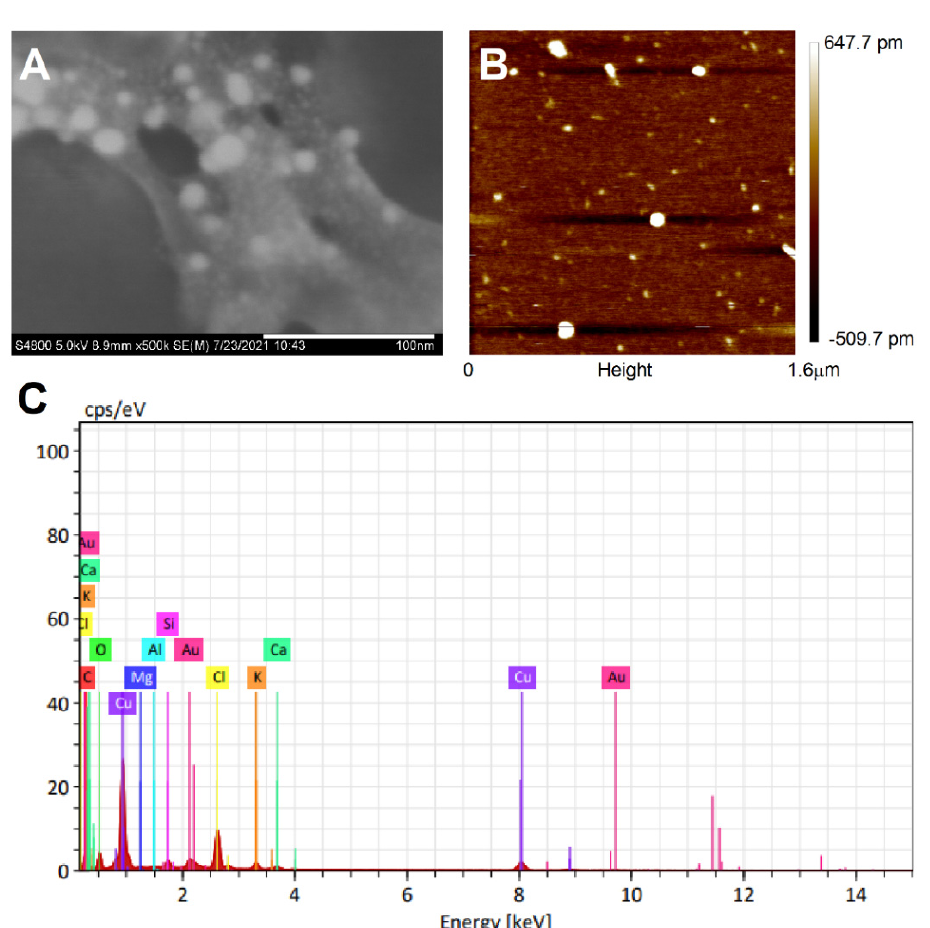
Figure 3. SEM ( A ) and AFM ( B ) images and EDX spectrum ( C ) of the synthesized Au NPs. SEM image scale bar: 100 nm.